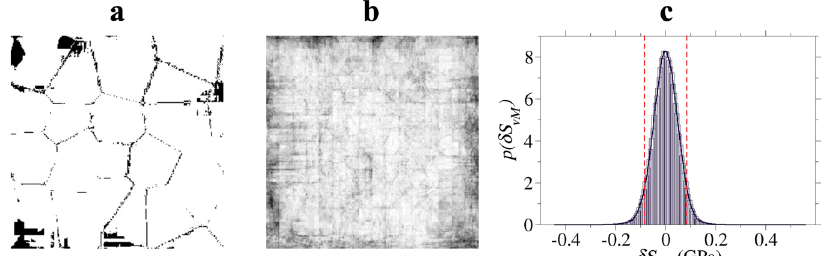
Fig. 2 Error distribution analysis for the case of elastic material response. Distribution of the absolute values of the deviations between the reference data obtained from the full- fi eld DAMASK based spectral solver simulations and the U-Net predictions ( a ), showing only regions with errors above 83 MPa (4% relative error) in black color for one of the test cases. b The local probability of occurrence of errors larger than 83 MPa. The probability is shown by a gray-scale color-code (the white and black colors represent the probability of zero and one, respectively). This quantity is calculated by averaging the observations similar to ( a ) over all the test data-sets. In this procedure for each of the test samples, a value of 1 is assigned to regions with an error above 83 MPa, and 0 otherwise. c Error distribution for all points in all of the 50 cases in the test data-set with 4% relative error indicated as red dashed